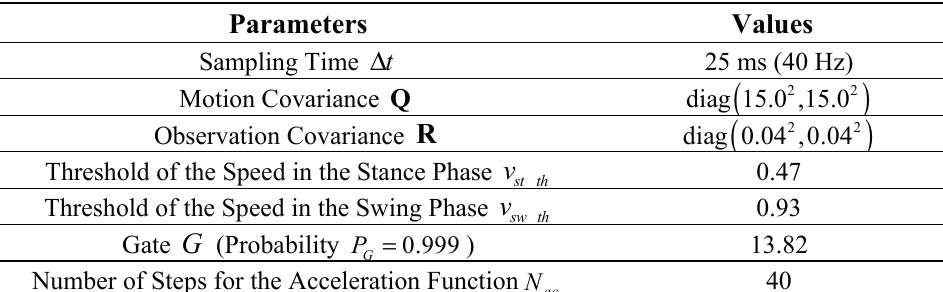
Figure 10. ( a ) Environmental field. ( b ) VICON markers were attached to the participant. ( c ) VICON analysis with the plug-in-gait model. Table 2. Proposed system